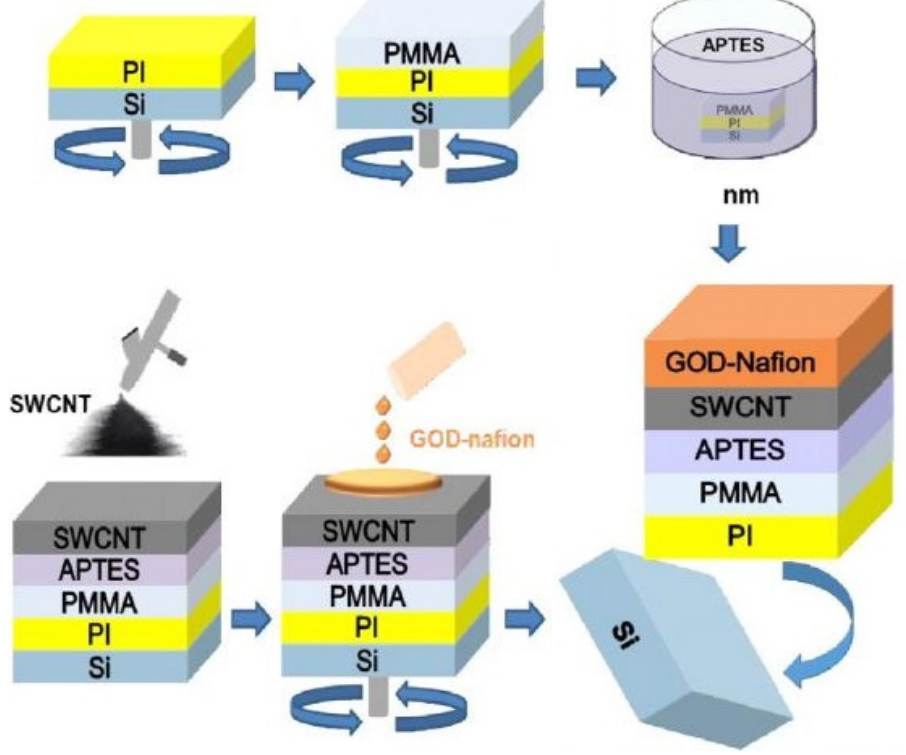
Figure 1. Schematic diagram of the fabrication process of SWCNT-based glucose sensors [123].